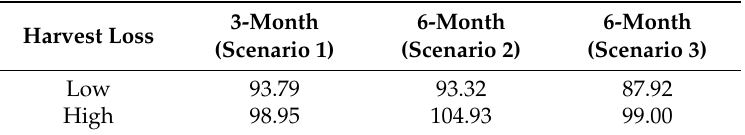
Table 9. Average cost (USD / Mg) of feedstock purchased at the SSL for achieved annual biorefinery operation (low productivity / fertilizer requirement).